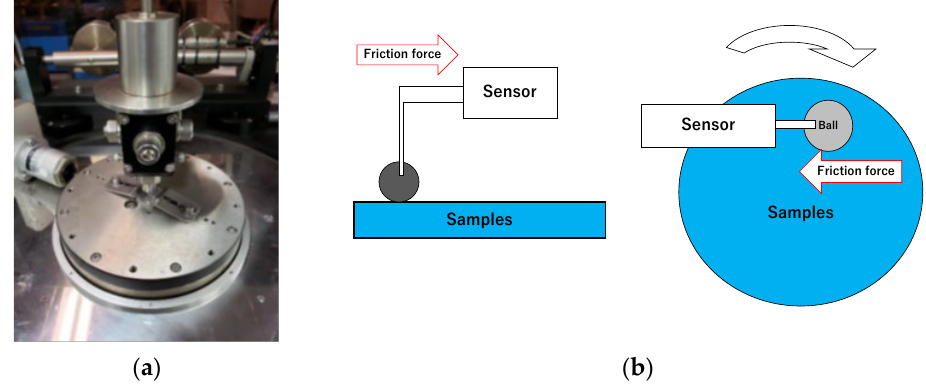
Figure 5. Ball-on-disk set-ups: ( a ) apparatus photo and ( b ) schematic illustration. Table 1. Conditions for the ball-on-disk test.